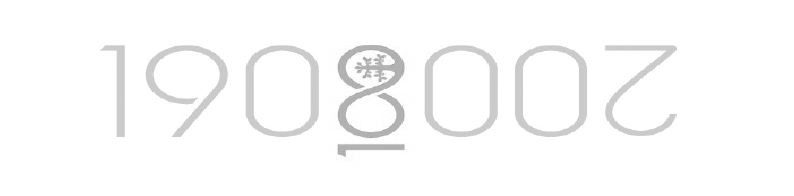
Fig. 21. Norwegian Midwifes Association’s 100th anniversary emblem and logotype.